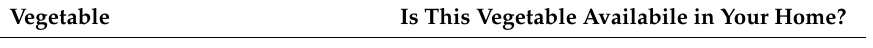
Table 1. Household food